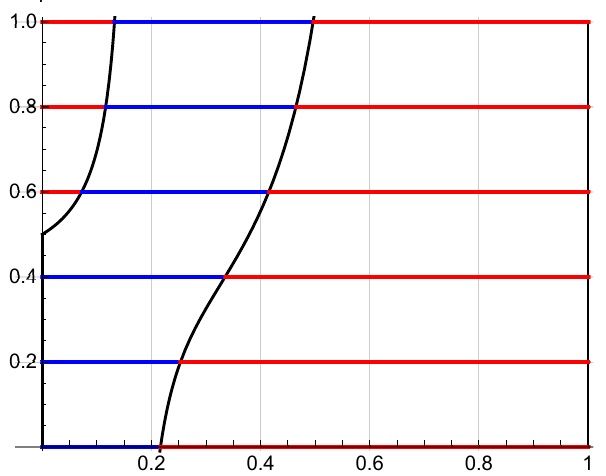
Figure 16. Potential distribution when there is a coupling between the second and third